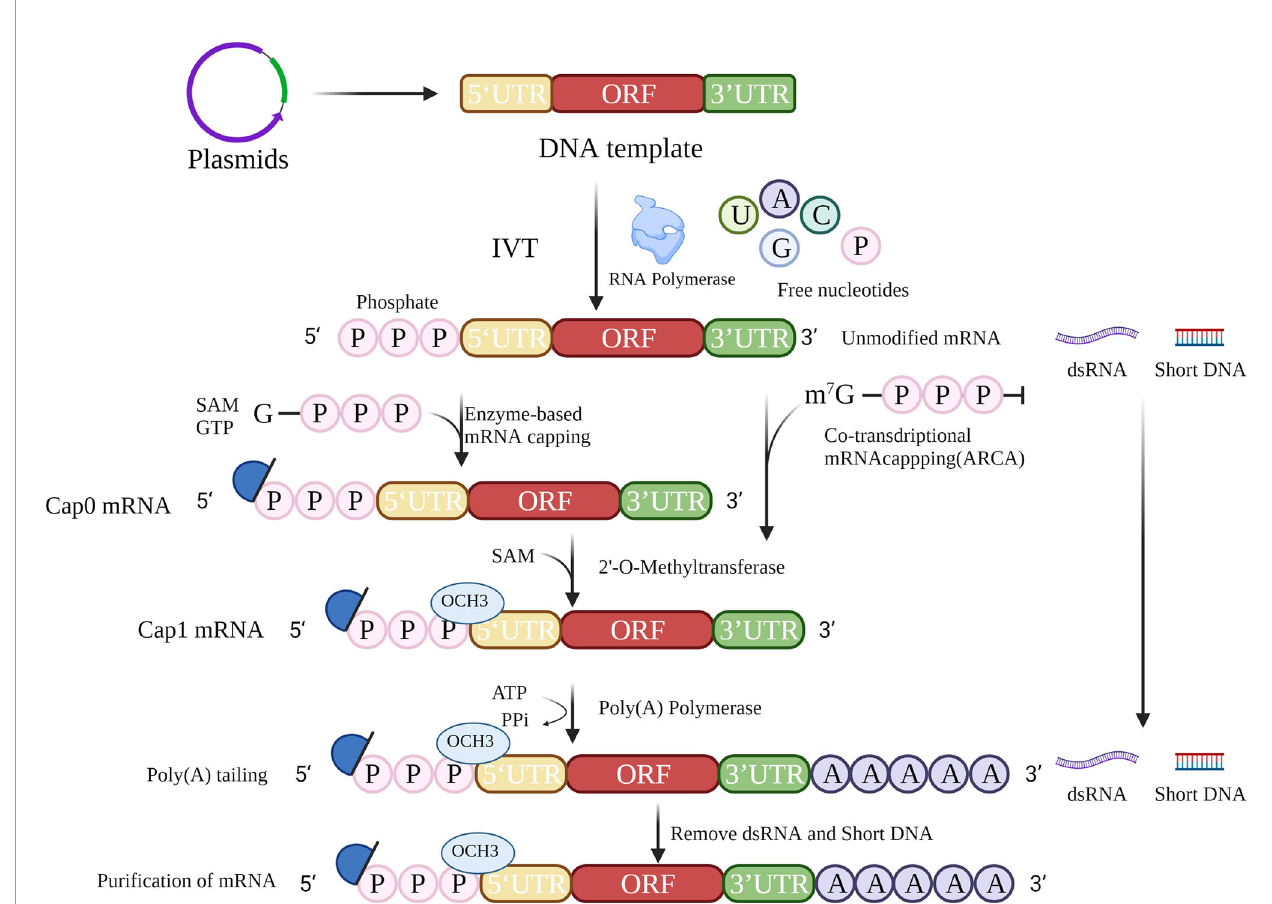
FIGURE 2 | mRNA in vitro transcription strategy. The strategy for mRNA preparation consists of template preparation, in vitro transcription, 5 ′ cap addition, 3 ′ poly (A) tailing, and puri fi